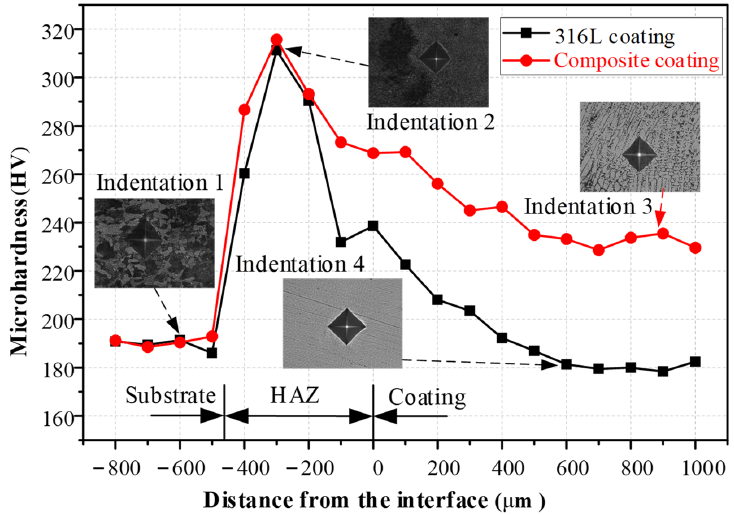
Figure 5. Microhardness distribution of 316L and composite coatings along building direction.